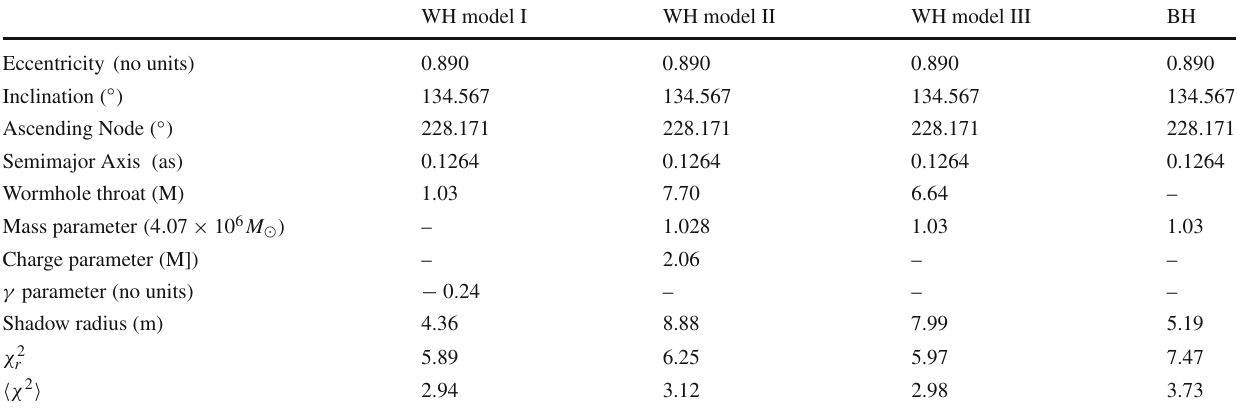
Table 1 Values of different parameters used and χ 2 r for each WH model and the black hole, respectively